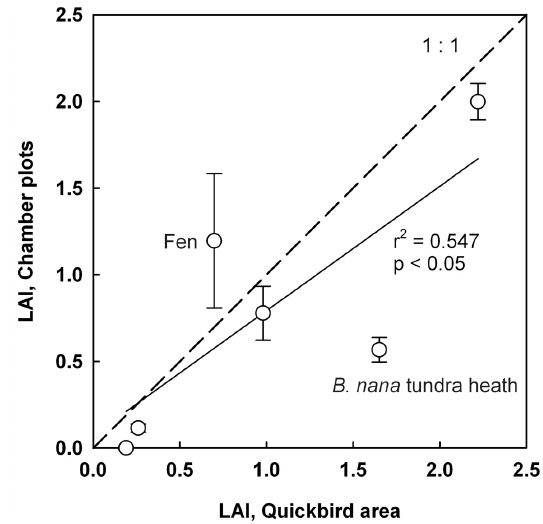
Fig. 2. Correlation of LAI values of different land cover types deter- mined by two independent methods: field measurements at chamber microsites (mean ± SD; n = 3–6) and modeling based on satellite image data for the QuickBird area of 98.6km 2 . The dashed line is a 1 : 1 line, and the solid line is a linear regression line fitted to the data. The two land cover classes deviating from 1 : 1 line have been